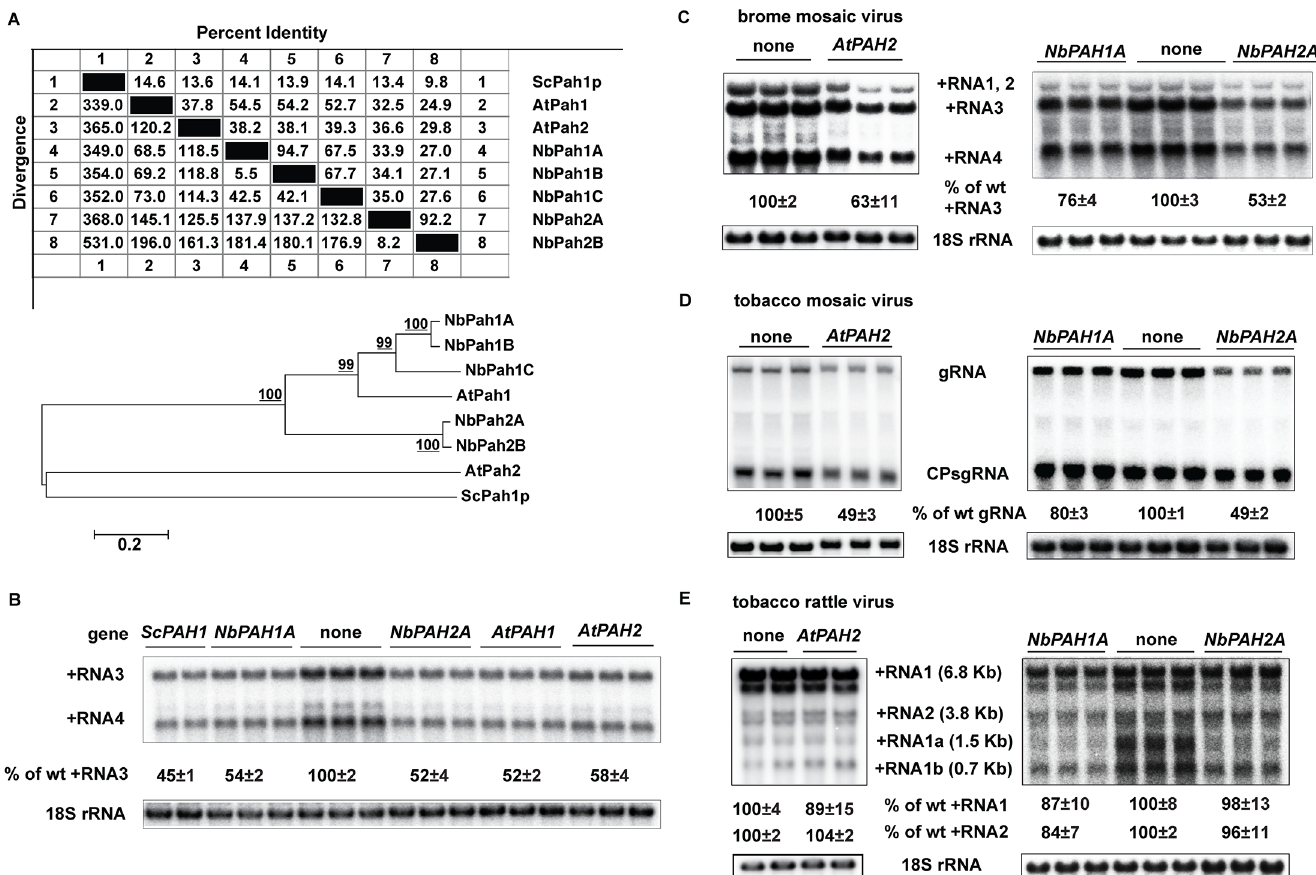
Fig 10. Expression of plant PAH1 homologs inhibits BMV replication in yeast and Nicotiana benthamiana . (A) Homology analysis and phylogenetic tree of Pah1 proteins from yeast (ScPah1p), Arabidopsis (AtPah1 and AtPah2), and N . benthamiana (NbPah1A, 1B, 1C, 2A, and 2B). (B) BMV replication in wt yeast cells expressing ScPAH1 , AtPAH1 , AtPAH2 , NbPAH1A or NbPAH2A . Positive-strand viral RNAs as well as 18S rRNA were detected as in Fig 1. Genome replications of BMV (C), TMV (D), or TRV (E) in N . benthamiana leaves expressing AtPAH2 , NbPAH1A or NbPAH2A . BMV, TMV, and TRV were launched by agroinfiltration in N . benthamiana leaves 2 days after agroinfiltration to express the plant PAH1 orthologs. Virus-infected leaves were harvested 3 days after agroinfiltration. RNA was extracted and viral positive-strand RNA was detected by using virus strand-specific probes as in Fig 1.